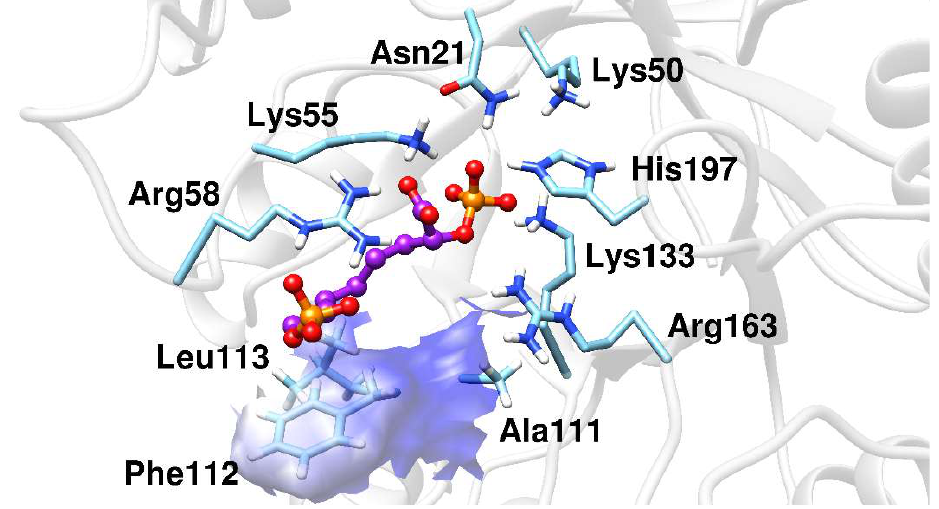
Figure 6. The BPH2 inhibitor having polar contacts at the active site of the KDO8P synthase.